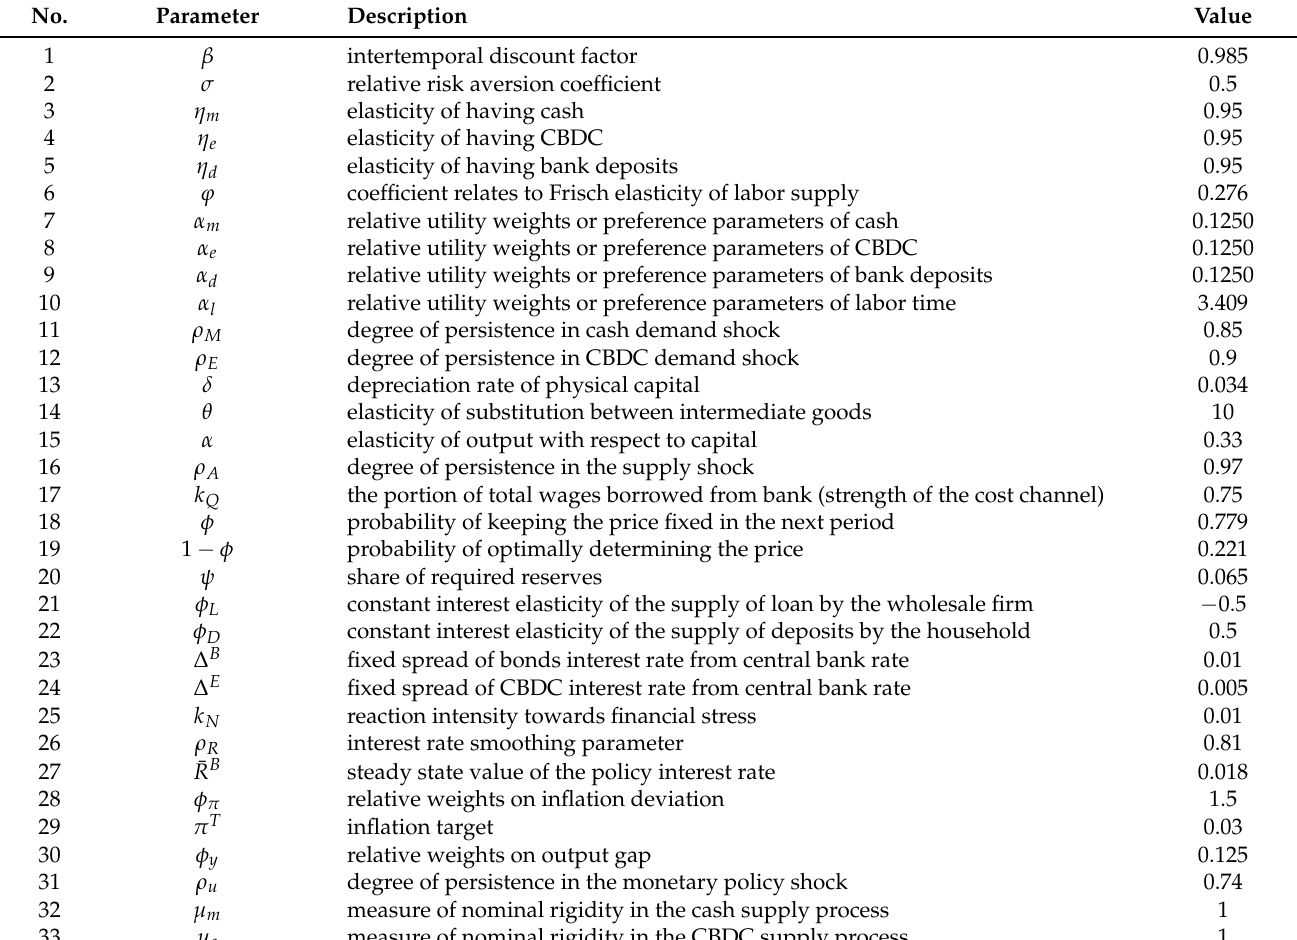
Table 1. The value of